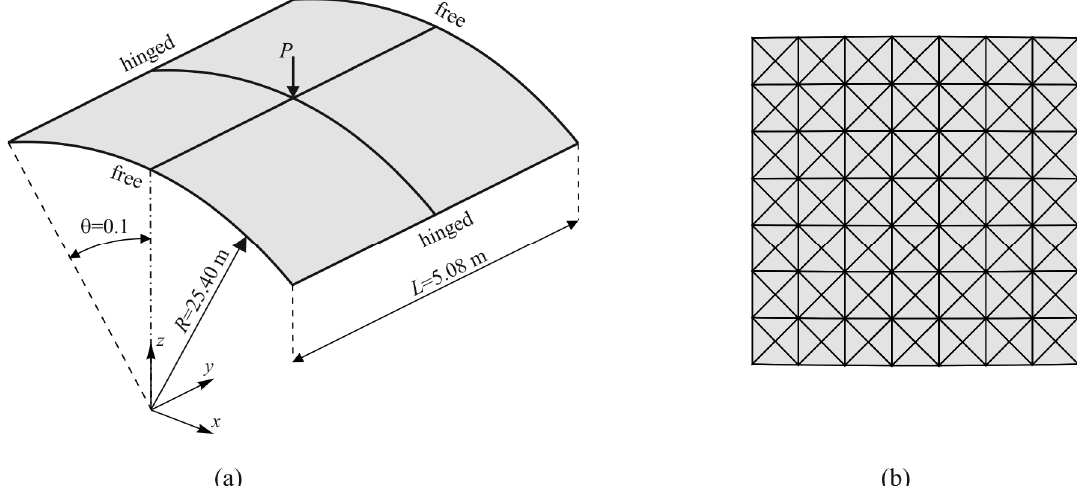
Figure 19. Hinged cylindrical roof exposed to the central pinching force: ( a ) problem description; and ( b ) meshes used for the numerical analysis.